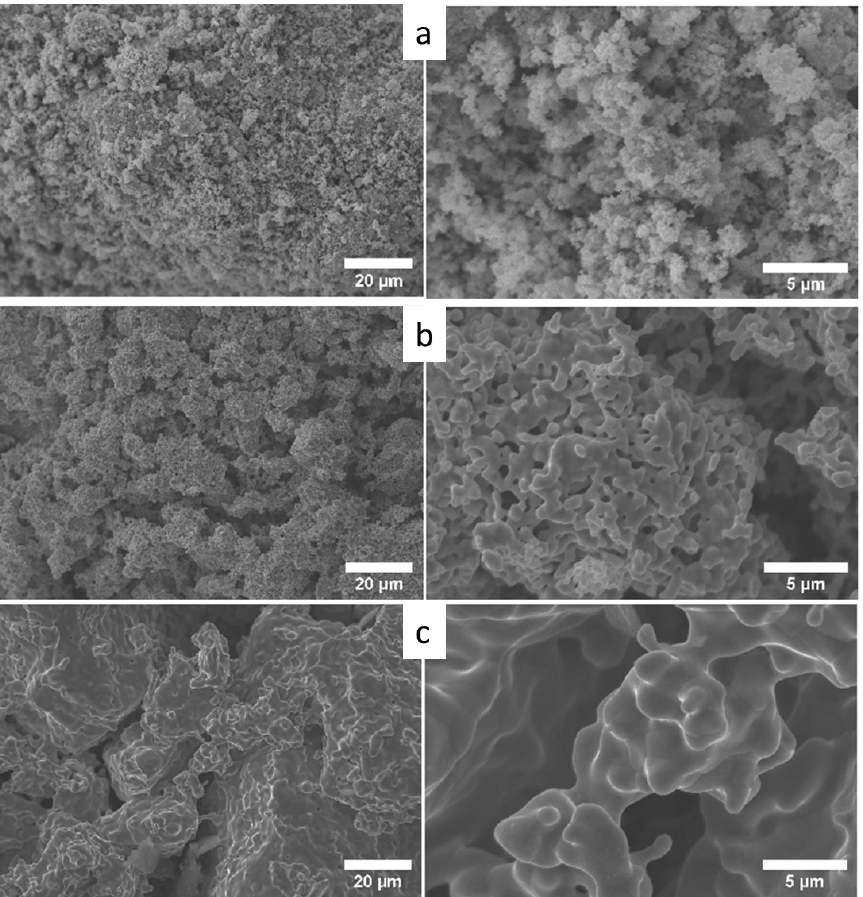
Figure 8. Secondary electrons SEM images under two magnifications of the co-formed ternary powder: 12Cu64Ni24Co for the different reduction temperatures: ( a ) 300 ◦ C; ( b ) 600 ◦ C; and ( c ) 900 ◦ C. Table 3. EDS results for each measured point of the 10Cu80Ni10Co